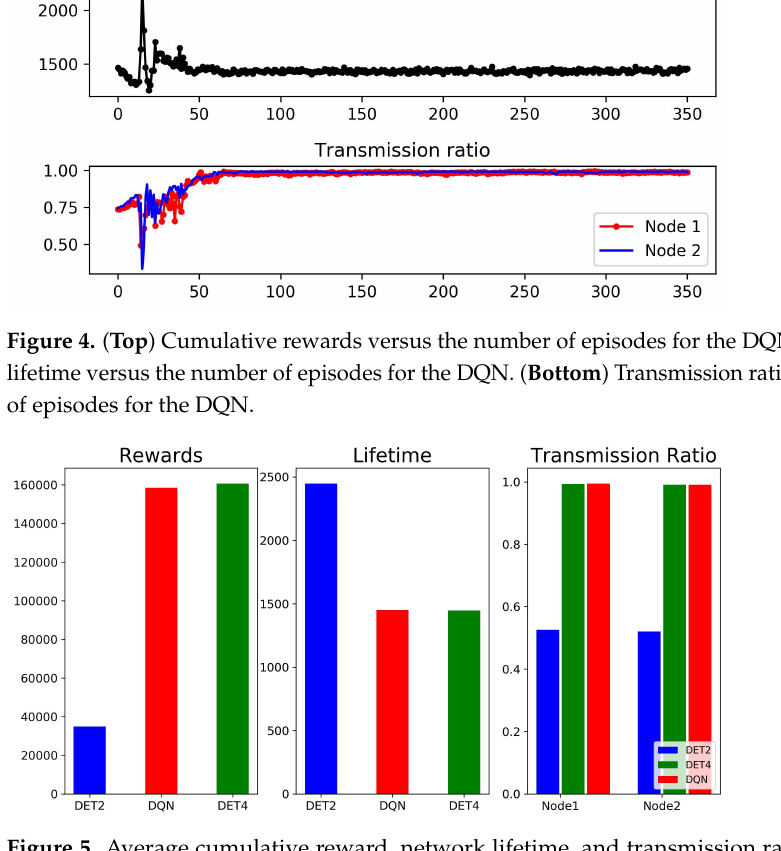
Figure 5. Average cumulative reward, network lifetime, and transmission ratio for the DQN and DET. DET2 and DET4 denote the DET cases with packet lifetimes of 2 and 4 s,